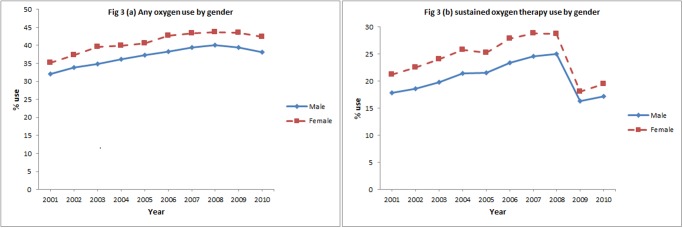
Any oxygen use by gender, (a), and sustained oxygen therapy use by gender, (b).